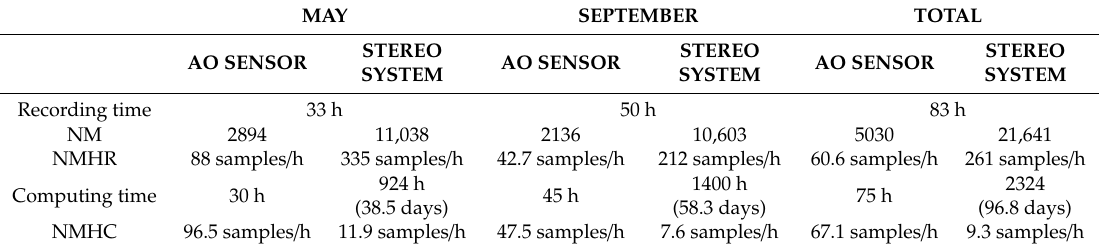
Table 3. Comparison between acoustic–optical (AO) sensor and stereoscopic system in terms of number of measurements and computing time. NM: number of measurements; NMHR: number of measurements per hour of recording; NMHC: number of measurements per hour of